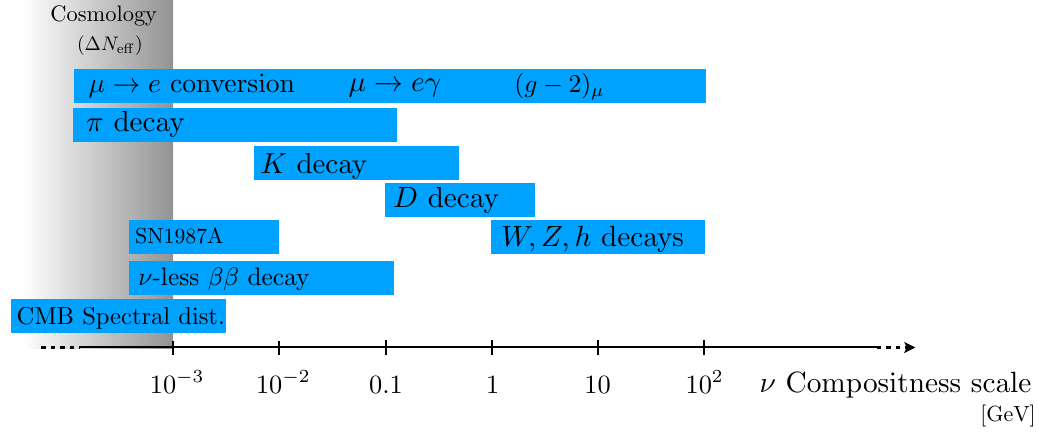
Figure 3 . A sketch of the various probes of neutrino compositeness and the range of compositeness scales that they are potentially sensitive